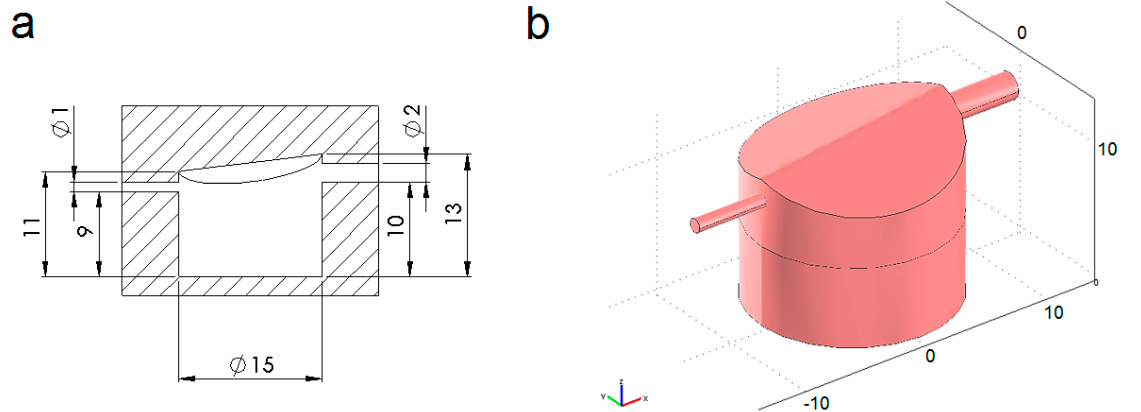
Figure 4. ( a ) Cross-section and ( b ) 3D view of the MCmB culture chamber. All dimensions are in